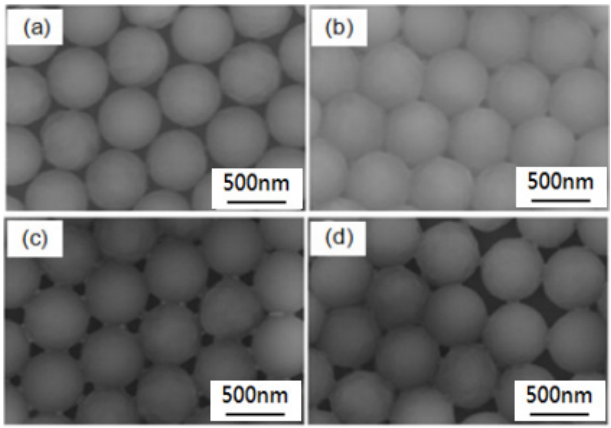
Figure 6. SEM images of self-assembly PS nanosphere masks fabricated with different evaporation temperatures during the self-assembly process. The evaporation temperature was ( a ) 25 °C; ( b ) 40 °C; ( c ) 55 °C; and ( d ) 70 °C.